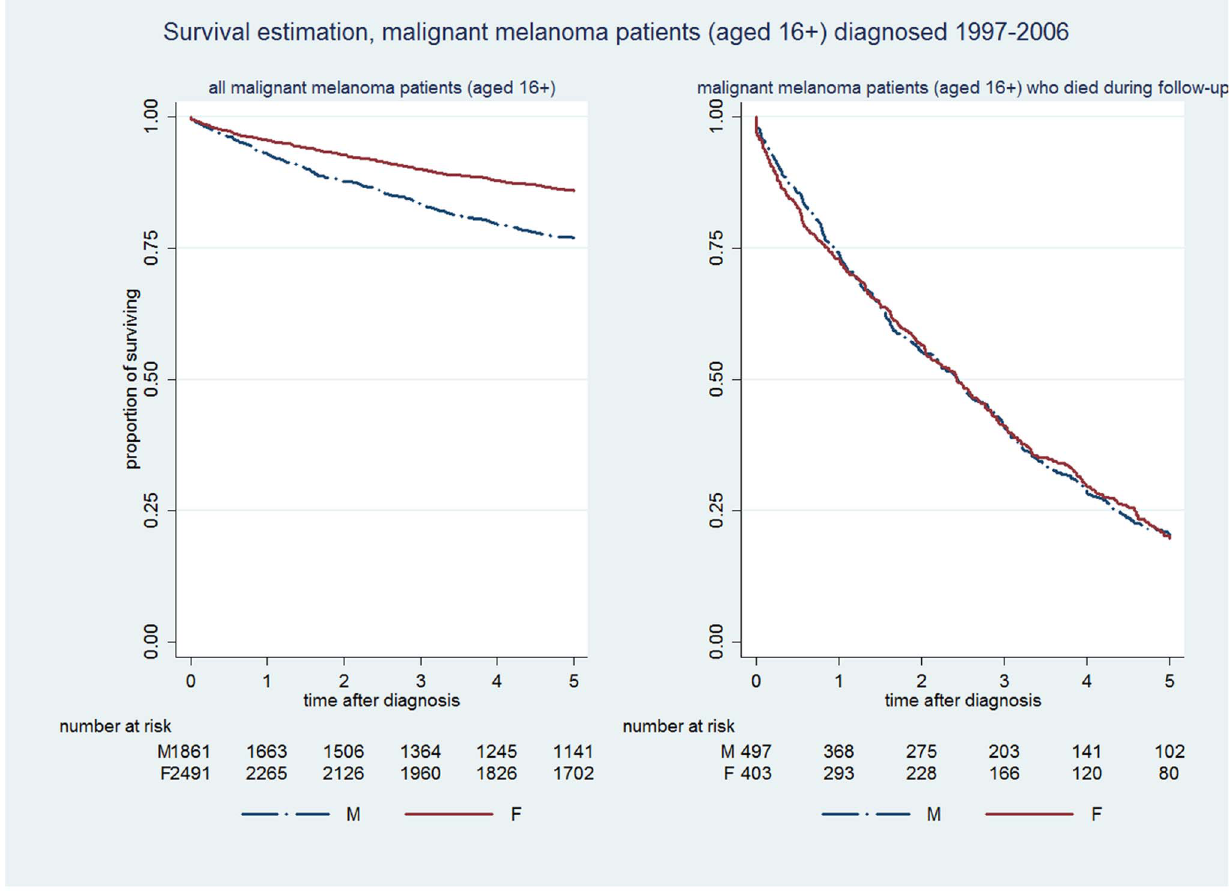
Figure 3. Kaplan-Meier survival curves for malignant melanoma patients (diagnosed between 1997–2006).